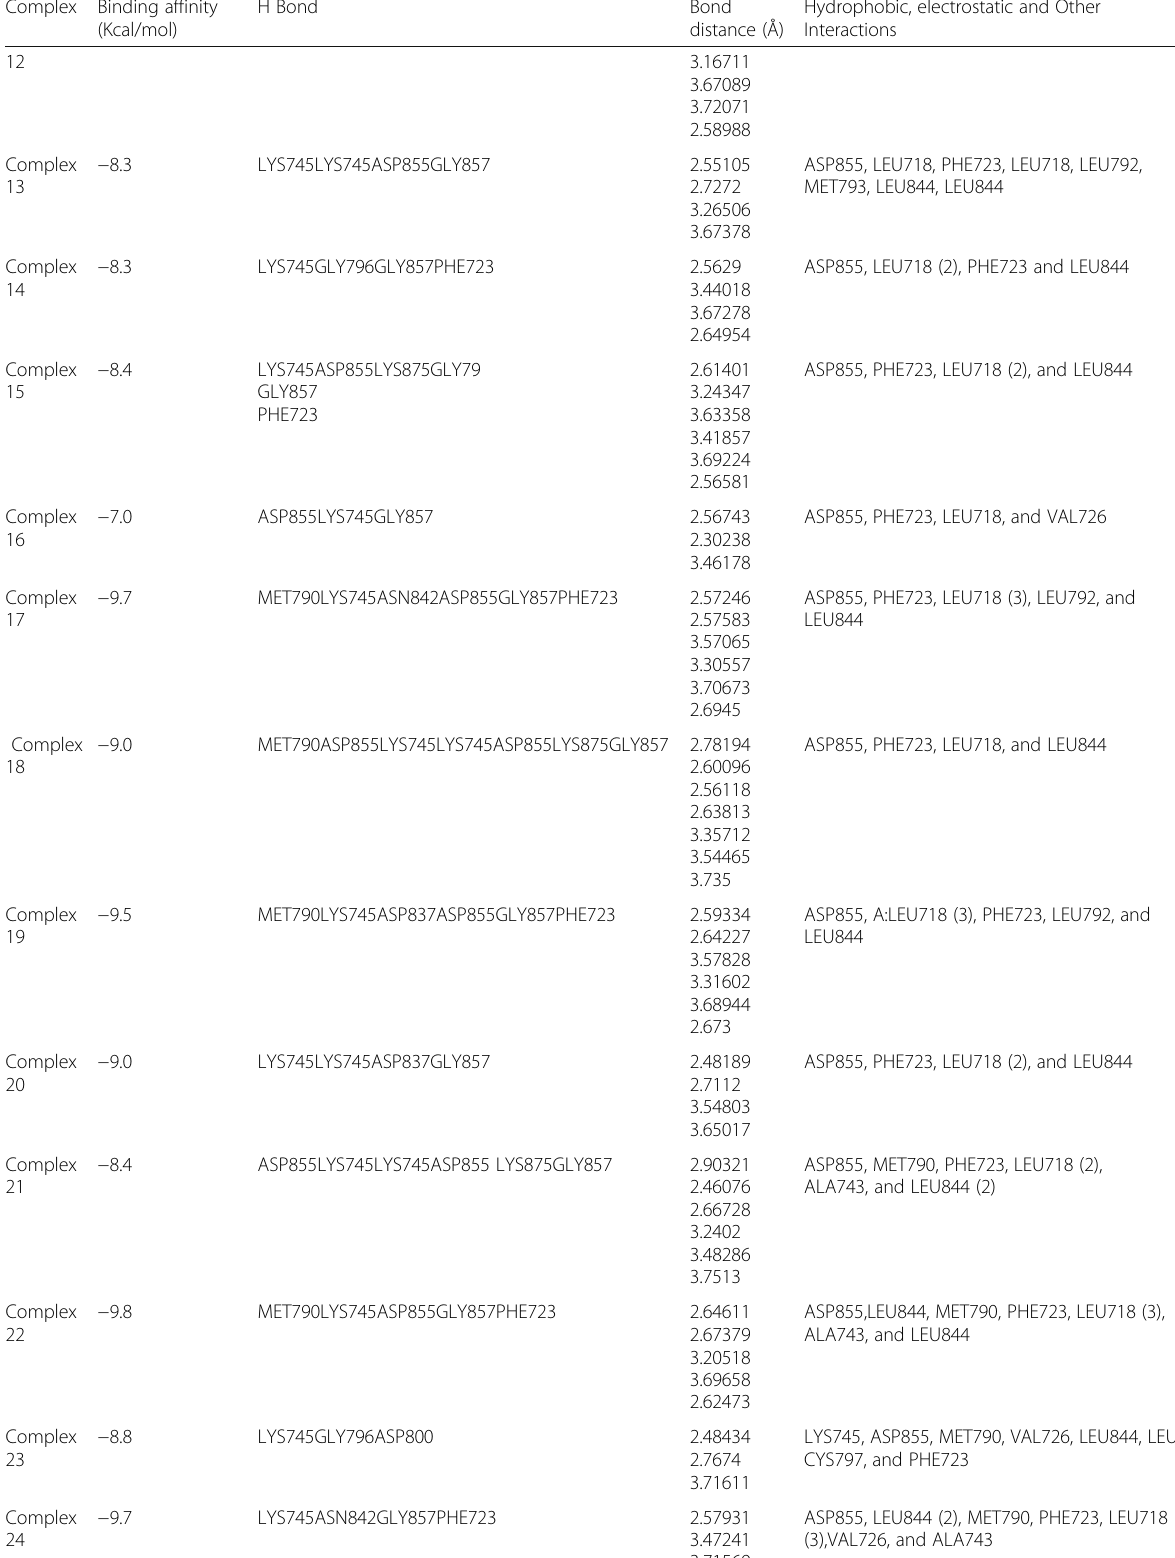
Table 2 The interactions of the molecules under investigation in the active site of EGFR receptor